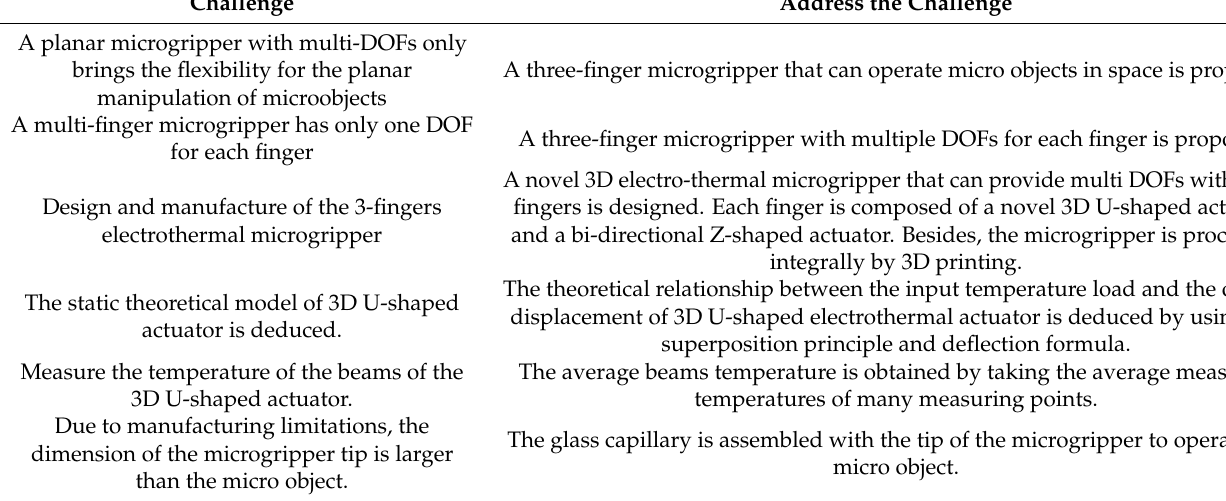
Table 1. Challenges and how to address